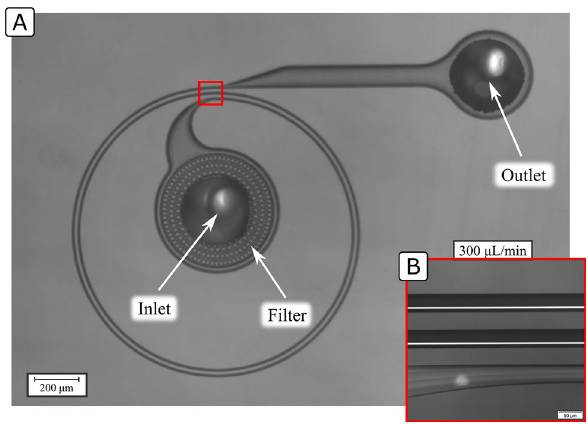
Figure 1. ( A ) Example of HARC system under the microscope. The red mark indicates the location where the high magnification pictures were taken for the evaluation of the performance of different devices. ( B ) Example of performance with 4 µm polystyrene particles from a HARC system with two loops, 41 × 84 µm ( WxH ) and R 25 mm.